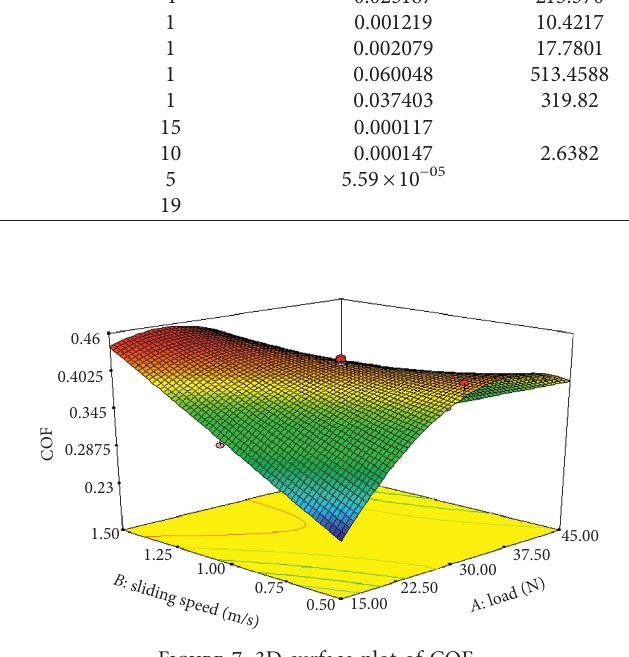
Figure 7: 3D surface plot of